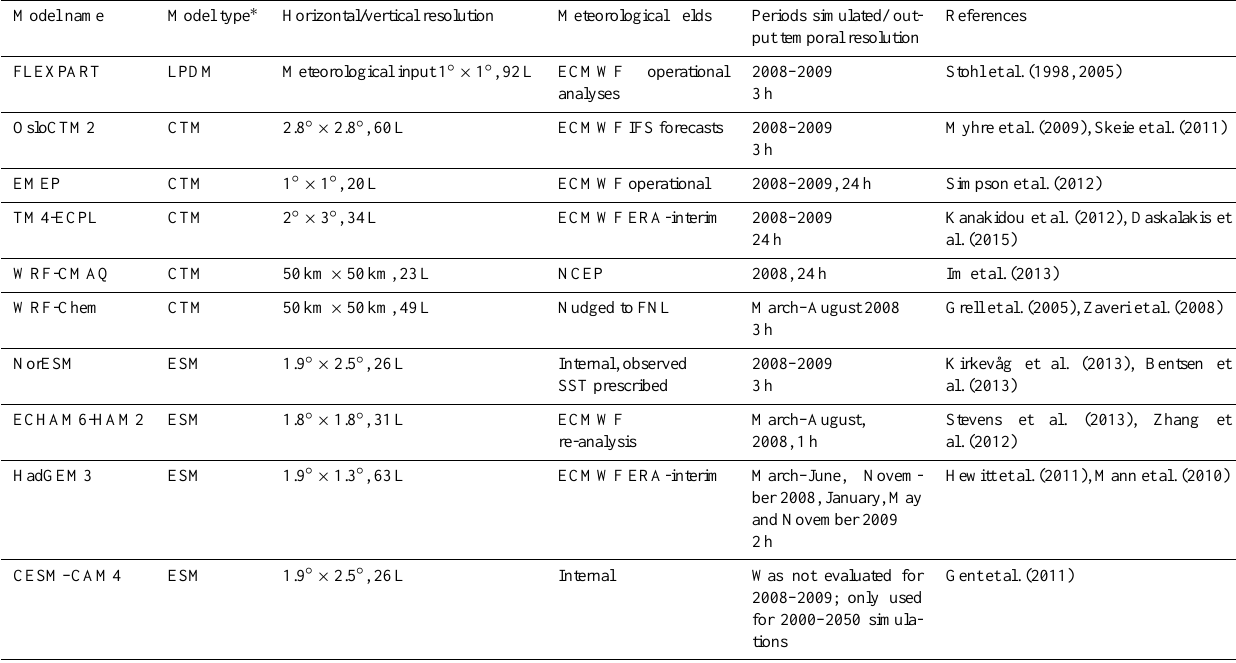
Table 2. Overview of the ECLIPSE models and how they were set up for the years